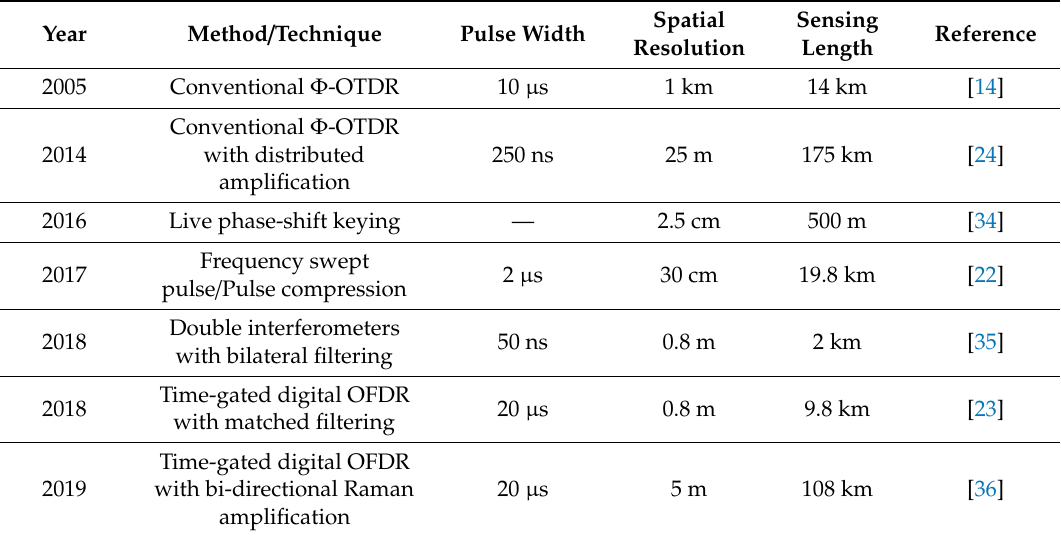
Table 1. Typical spatial resolution with di ff erent